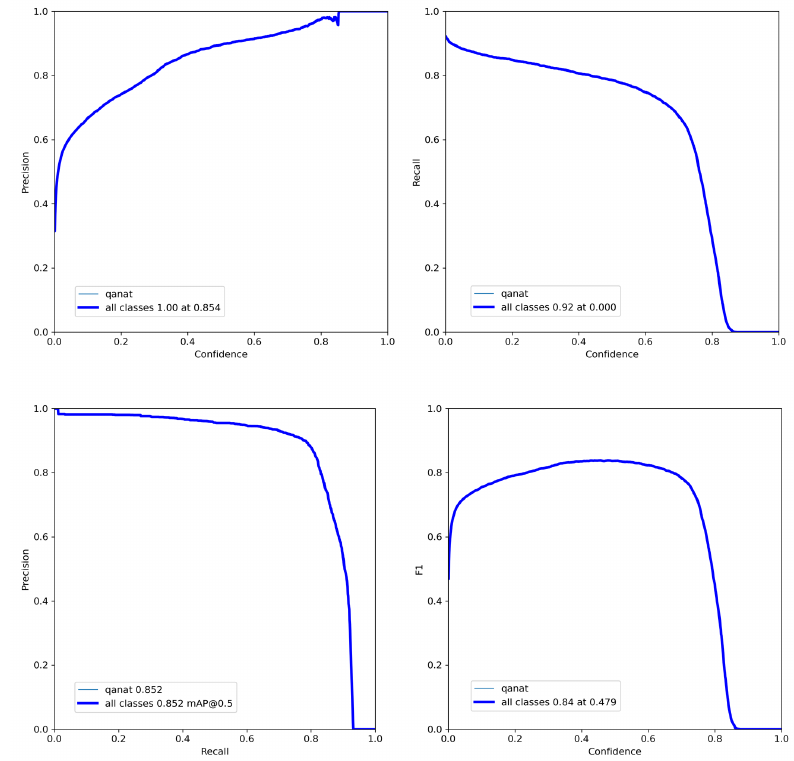
Figure 7. Accuracy index diagram of YOLOv5 model.